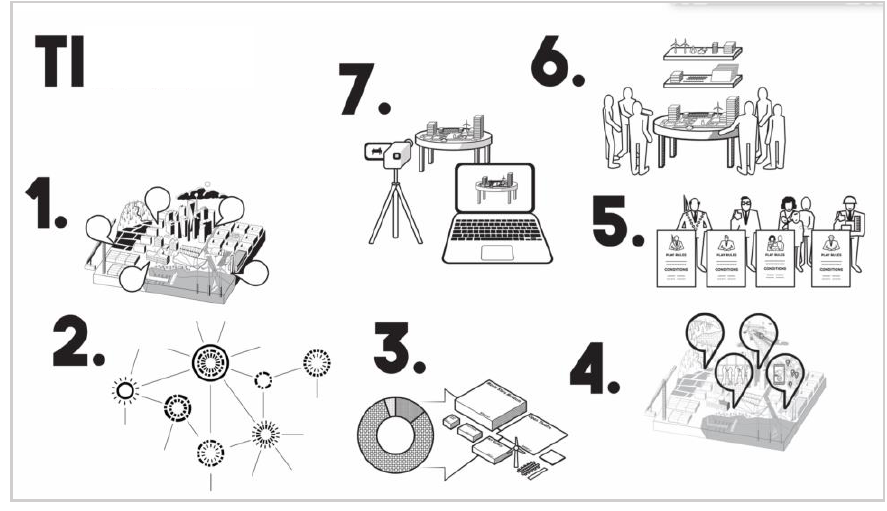
Figure 6 City-Gaming methodology applied during sessions (Tan,